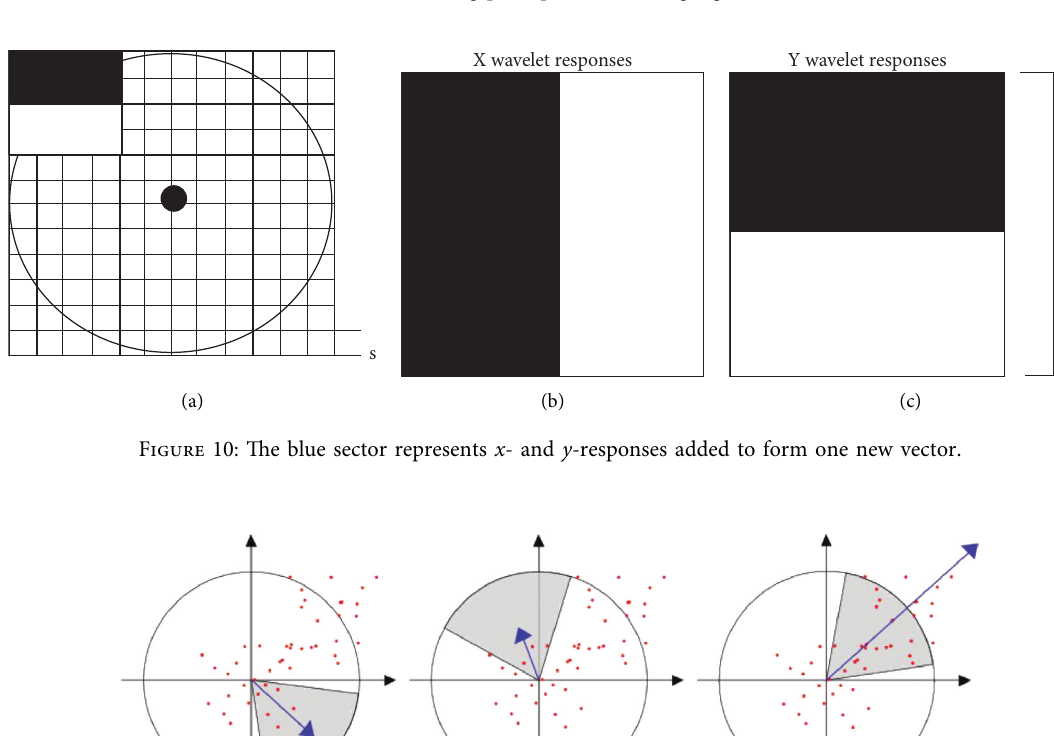
Figure 9: Working principle of clustering algorithms.